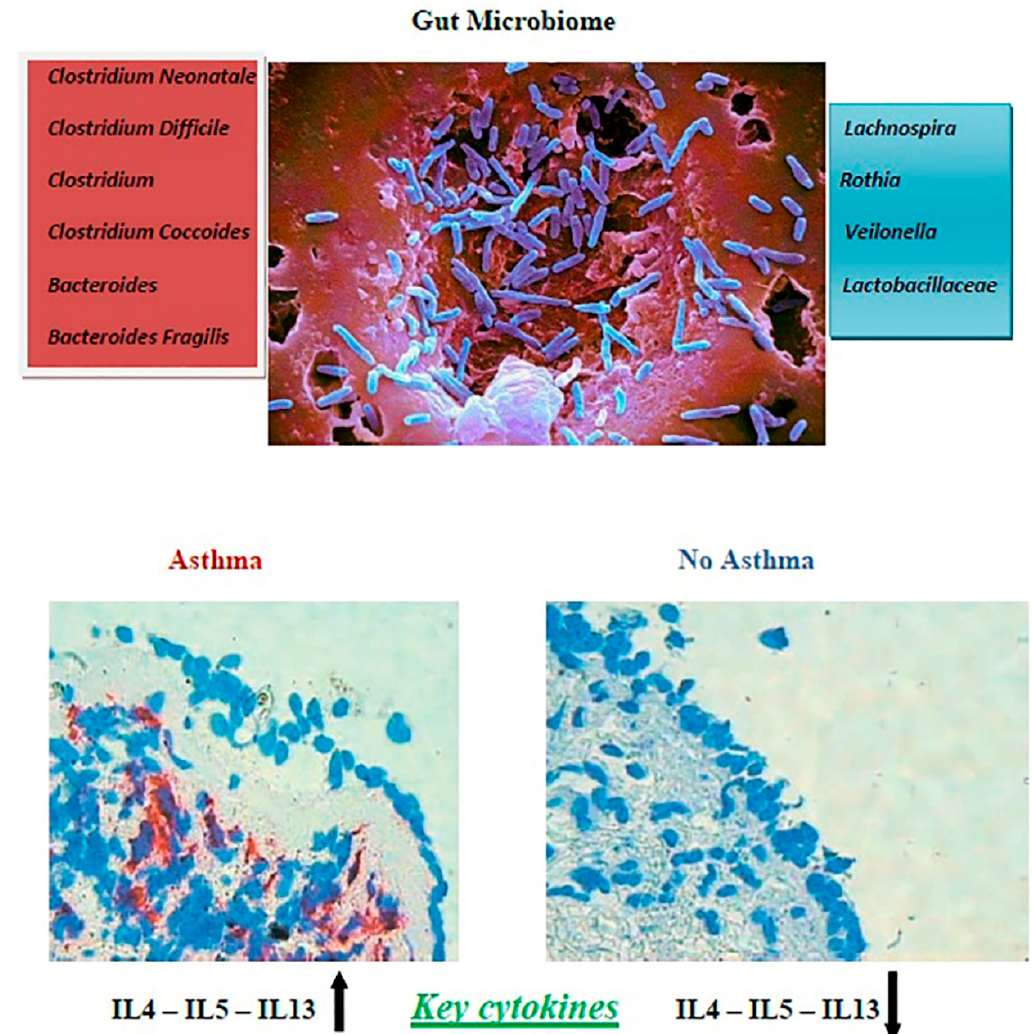
Figure 1. Differences in the lung bacterial microbiota between asthmatic and healthy children. In the upper section, the names and the image of pathogens that can influence asthma development are represented. In the lower section, on the left it is shown the respiratory tract of an asthmatic child with an increase in interleukin (IL)-4, IL-5, and IL-13; on the right is shown the respiratory tract of a healthy child with normal values of IL-4, IL-5, and IL-13.